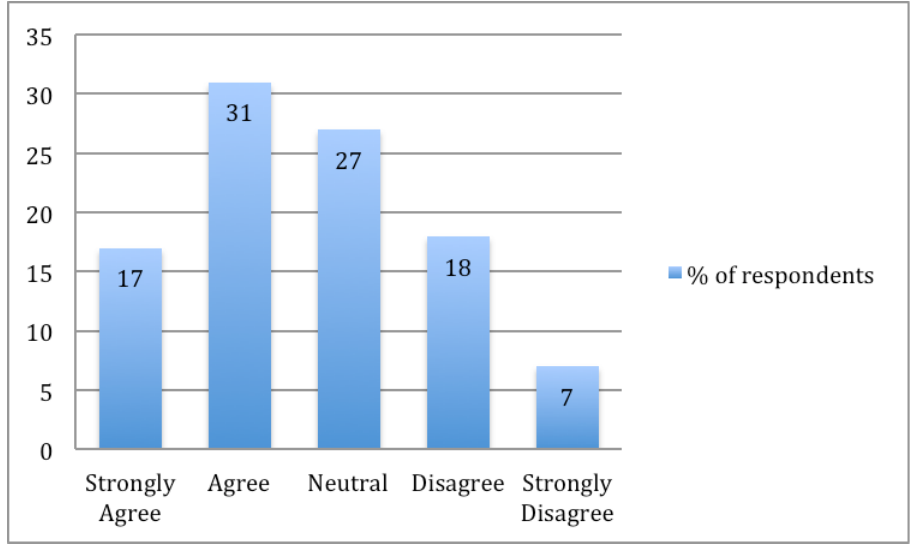
Figure 5. Concerns over copyright and IPR